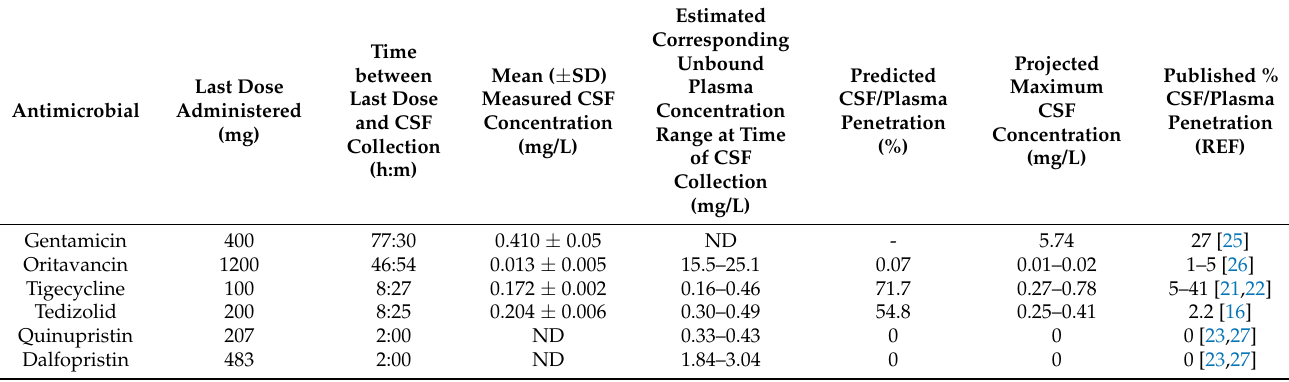
Figure 3. Mean log 10 cfu/mL versus time profile for each individual drug alone and in combination at their respective measured CSF concentration and extrapolated maximal CSF concentration against the VREf isolate cultured from CSF on hospital day 33. Curves represent average concentrations for triplicate experiments. Table 2. Mean ( ± SD) measured CSF concentrations of each agent quantified from the day 57 lumbar puncture along with estimated maximum CSF concentrations and CSF/plasma penetration